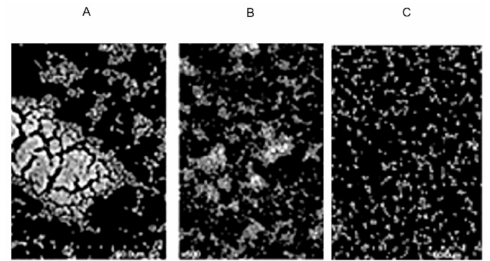
Figure 5. Effect of semi-purified CFS of strain XN2 on the biofilm formation of S. aureus ; ( A ): con- trol ( S. aureus cells treated with no semi-purified CFS); ( B ): with 1/2 MIC semi-purified CFS; and ( C ): with 2 MIC semi-purified